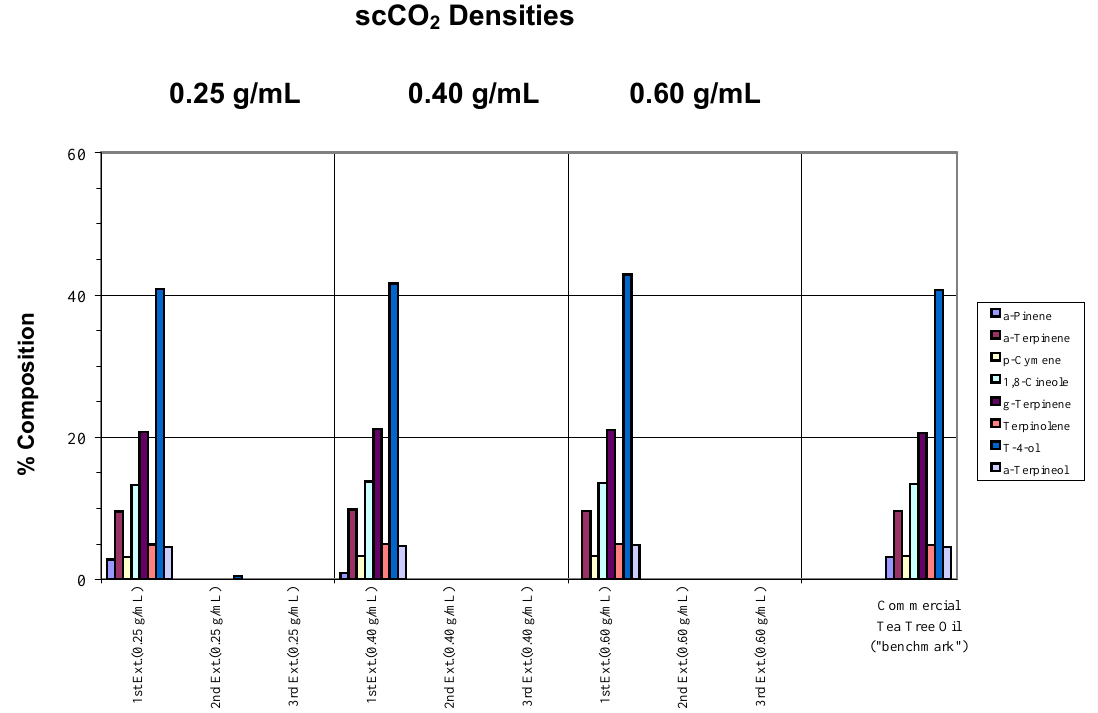
Figure 1. Effects of different conditions on the extraction of commercial tea tree oil from a simple matrix. The chamber temperature was set at 40 o C. Note in the chart legend that ol” was used in place of Terpinen-4-ol, and so on. “Ext.” has been used to